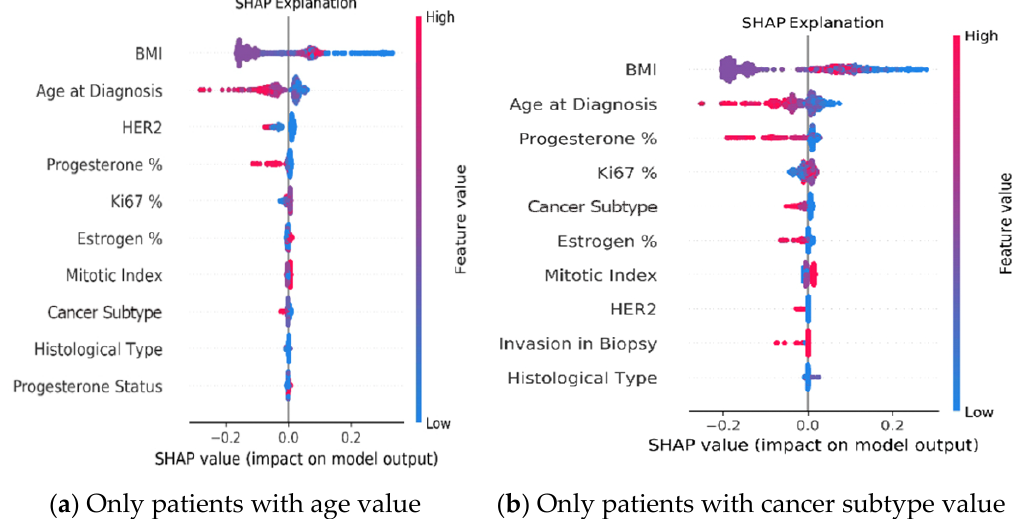
Figure A2. Clinical feature contribution with subsets of training data. ( a ) Training with only the patients that have age value. ( b ) Training with only the patients that have cancer subtype value.